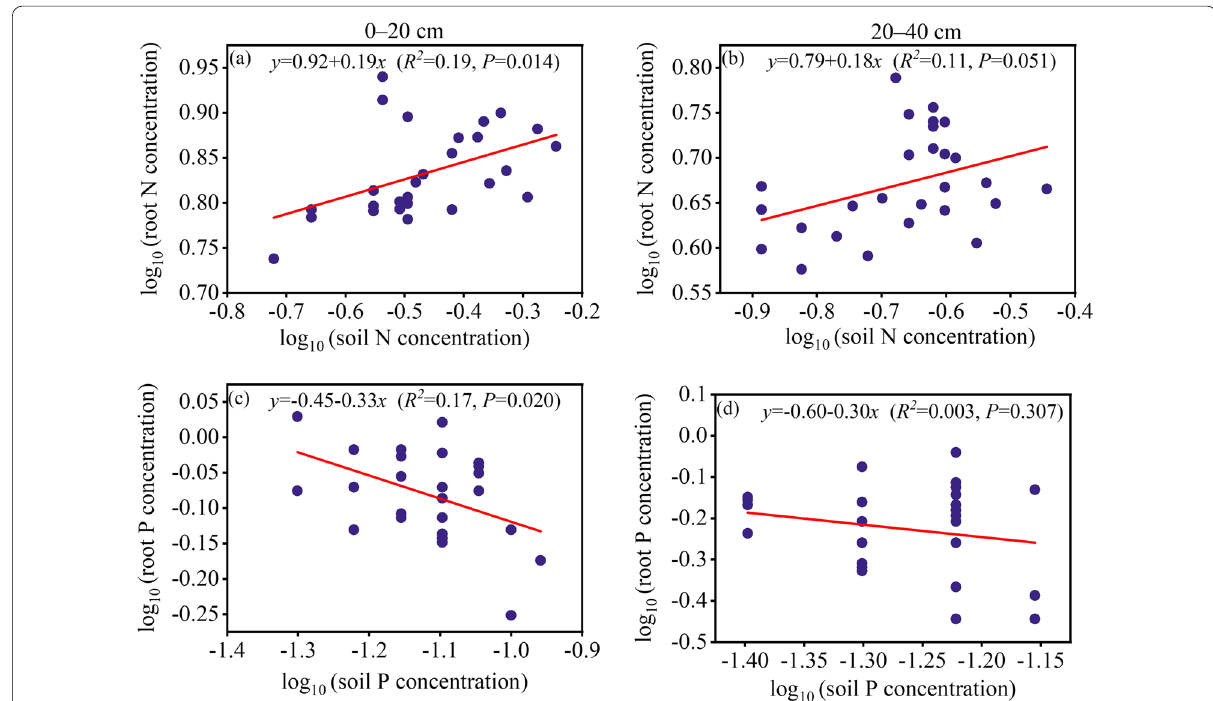
Fig. 7 Relationships of log 10 ‑transformed N and P concentrations between plant roots and soil in 0–20 and 20–40 cm soil